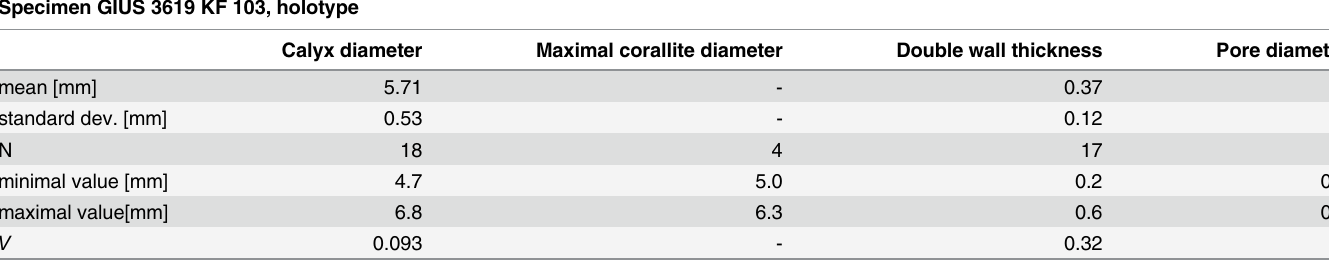
Table 1. Intracolonial variation in ? Michelinia vinni sp. nov. Specimen GIUS 3619 KF 103,